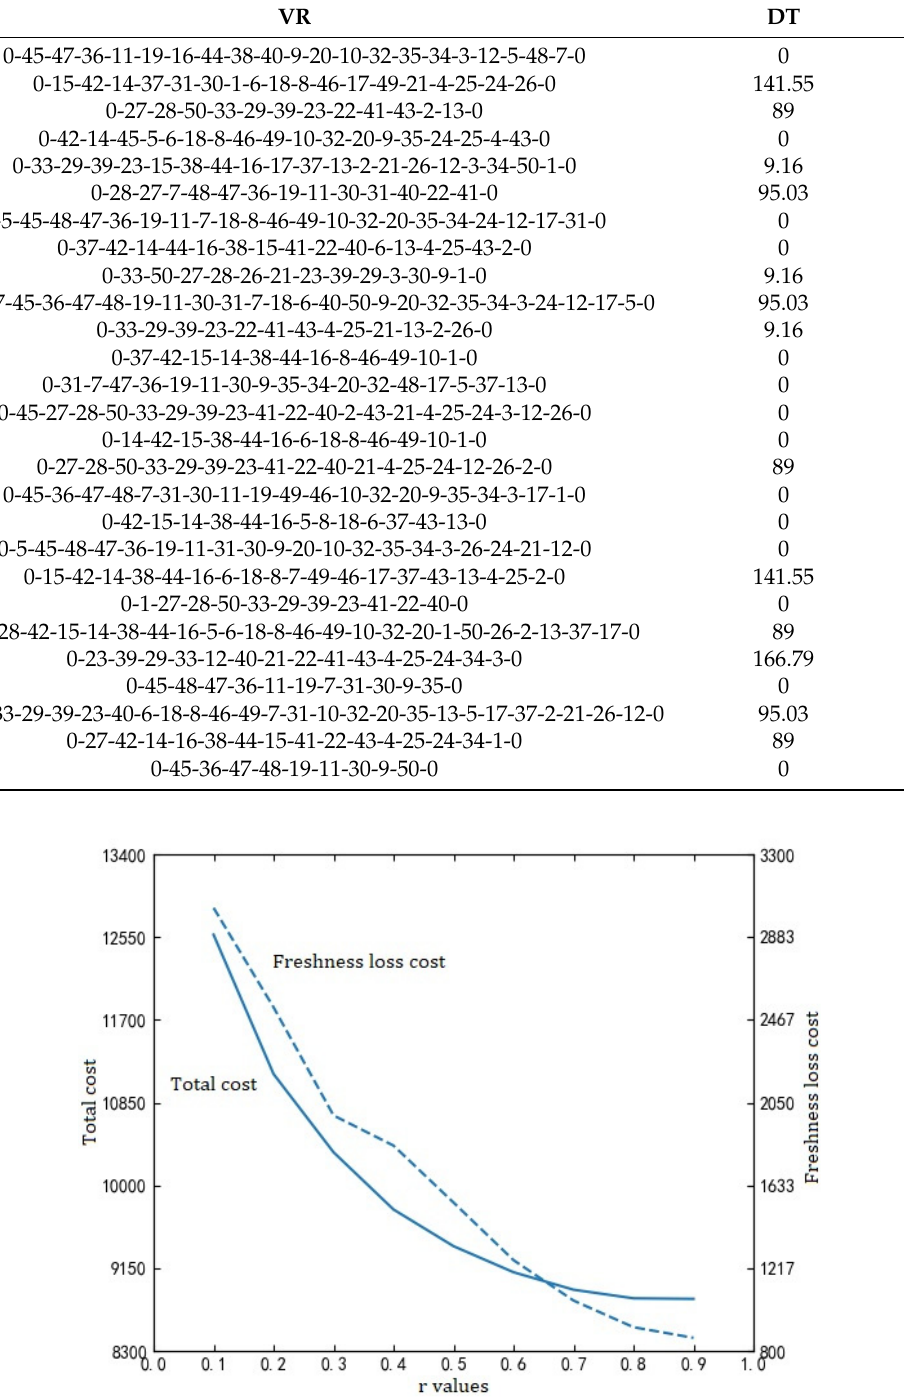
Figure 8. Adjustment factor and cost curve.